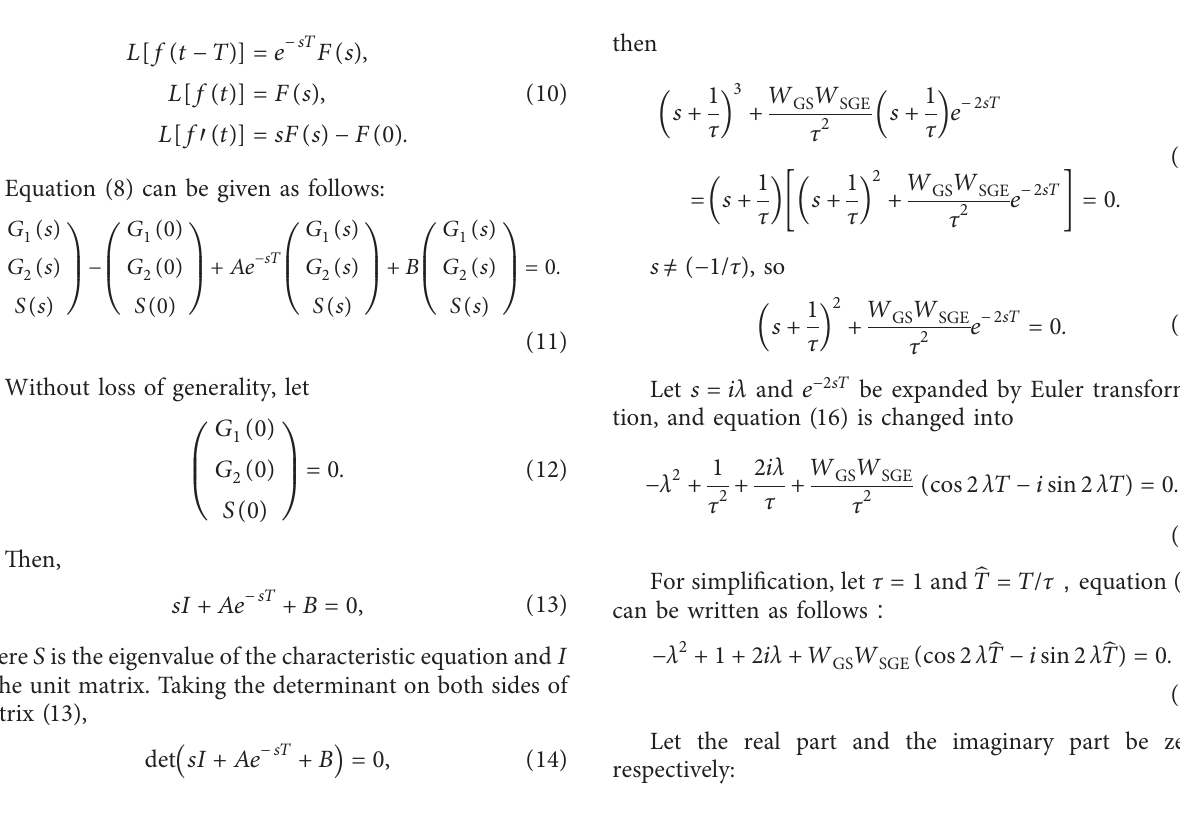
Figure 3: Time series of systems (1)–(3): (a) Parkinson’s disease and (b) healthy